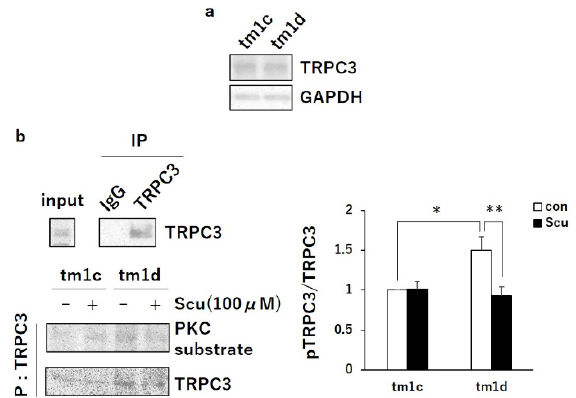
Figure 4. TRPC3 upregulation in tm1d mice: ( a ) cerebellar lysates from tm1c and tm1d mice were subjected to Western blotting and probed with anti-TRPC3 and anti-GAPDH antibodies. ( b ) Acute cerebellar slices from tm1c and tm1d mice were incubated with or without Scu (100 µM) for 1 hour and subsequently were homogenized. Then, the lysates were immunoprecipitated using anti-TRPC3 antibody. The immunoprecipitates were subjected to western blotting and probed with anti-PKC substrate and anti-TRPC3 antibodies. IgG (anti-GRIP antibody) was used as a control. Quantification of the phosphorylation level of TRPC3 was performed by ImageJ and was normalized to the total level of TRPC3. The ratio of the phosphorylation level of TRPC3 to the control (con) in tm1c was plotted (n = 7); * p < 0.05, ** p < 0.01, followed by Tukey’s multiple comparisons test. Data are expressed as mean ± SEM. Con means control.